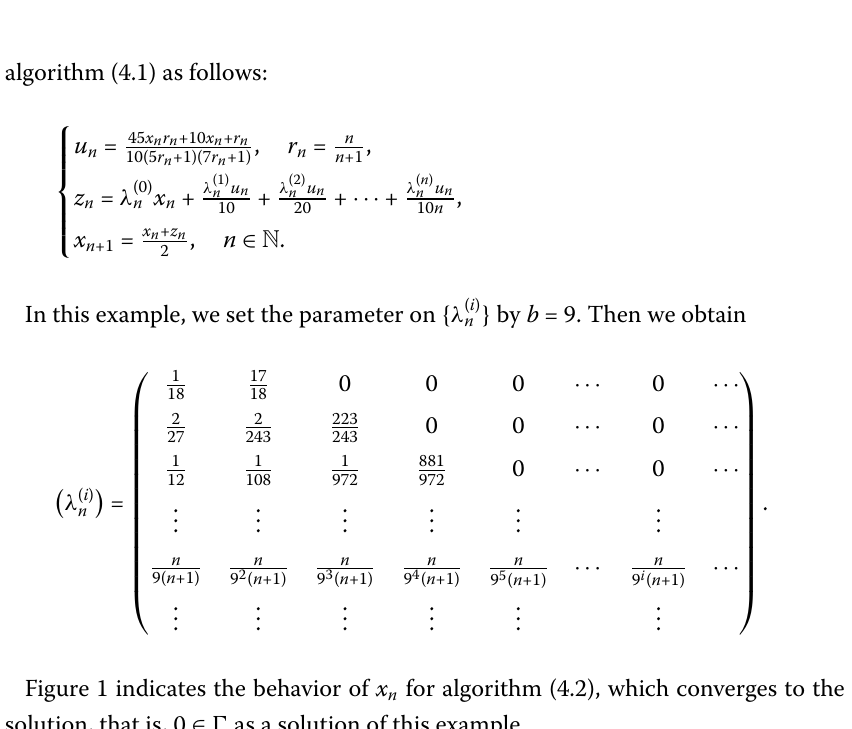
Figure 1 Behaviors of x n with three random initial points x